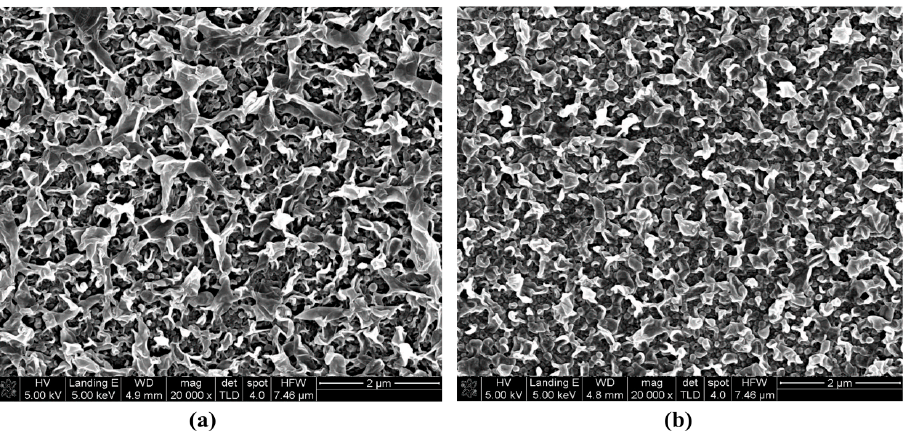
Figure 5. SEM images of the neat membranes: ( a ) FEn; ( b ) FLR (×20,000).